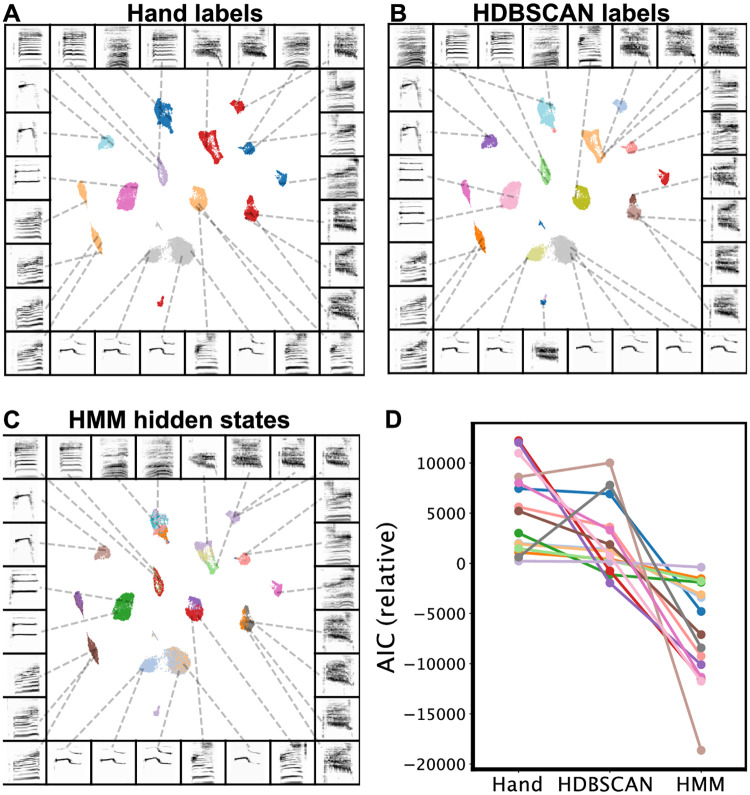
Comparison of Hidden Markov Model performance using different hidden states.Projections are shown for a single example bird from the Koumura dataset [64]. UMAP projections are labeled by three labeling schemes: (A) Hand labels (B) HDBSCAN labels on UMAP, and (C) Trained Hidden Markov Model (HMM) labels. (D) Models are compared across individual birds (points) on the basis of AIC. Each line depicts the relative (centered at zero) AIC scores for each bird for each model. Lower relative AIC equates to better model fit.